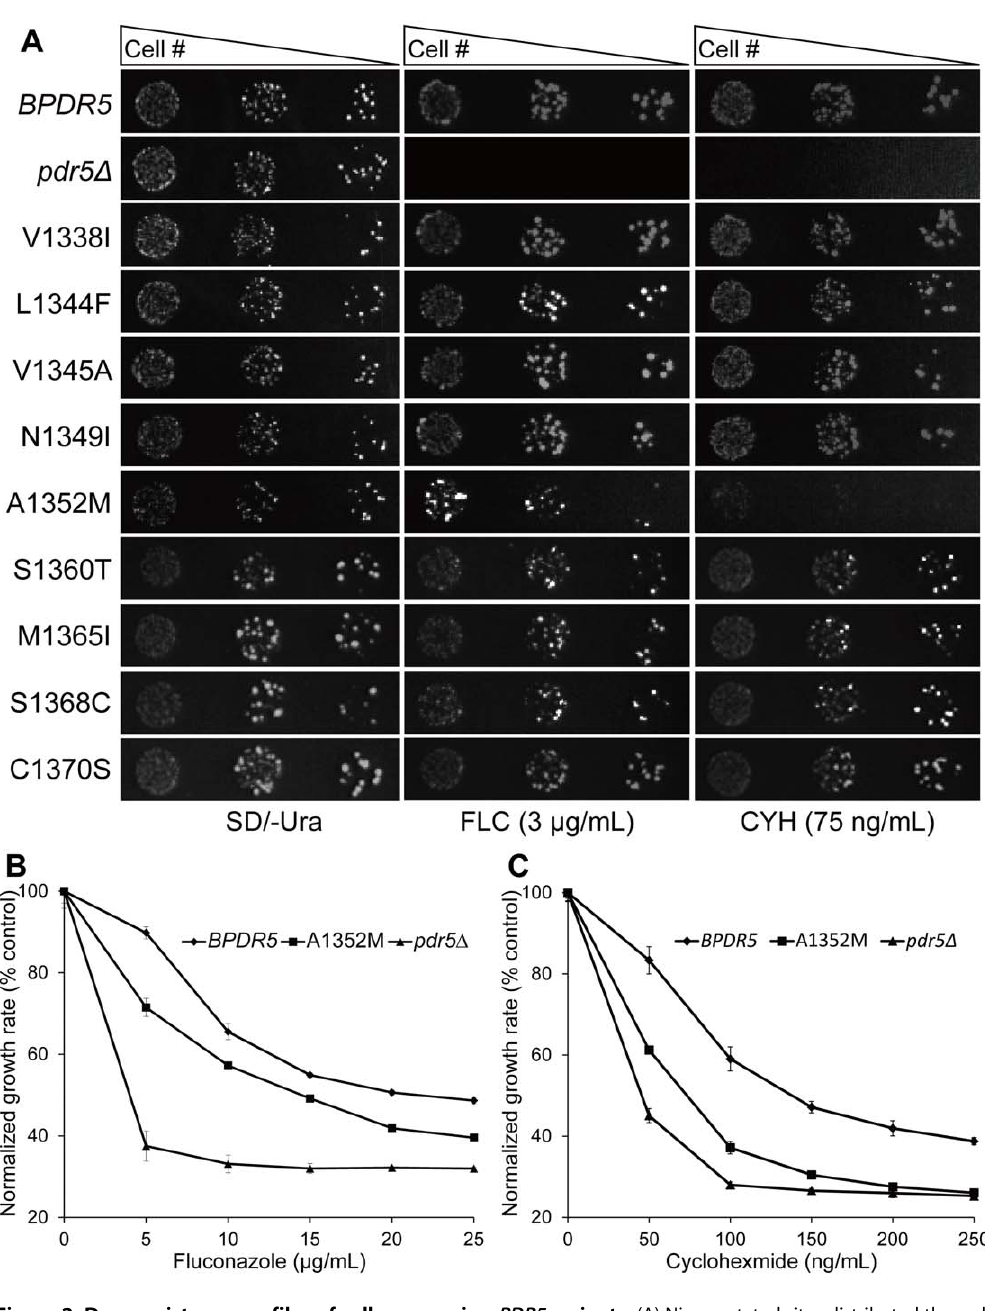
Figure 2. Drug resistance profiles of cells expressing PDR5 variants. (A) Nine mutated sites distributed throughout blocks S2A and S2B were separated by site-directed mutagenesis and fluconazole sensitivities of mutant variants were determined by spot assay. Cells were grown overnight and reinoculated to OD600=0.1, then 4 m L of five-fold serial dilutions were spotted onto drug free or drug containing (3 m g/mL fluconazole or 75 ng/ mL cycloheximide) SD/-Ura plates. The plates were incubated at 30 u C for 72 hours. (B) Resistance of BPDR5 ( X ), pdr5 D ( m ) and A1352 ( & ) mutants to increasing concentrations of fluconazole. Cells from overnight cultures were inoculated to OD600=0.1. Growth was estimated on the basis of OD600 and plotted as percentage growth, where the growth in drug free media was taken to be 100%. The mean values of three independent experiments are plotted and the error bars represent the S.D. (C) Growth of BPDR5 ( X ), pdr5 D ( m ) and A1352 ( & ) mutants was compared as described in B, except that the experiment was performed in the presence of increasing concentrations of